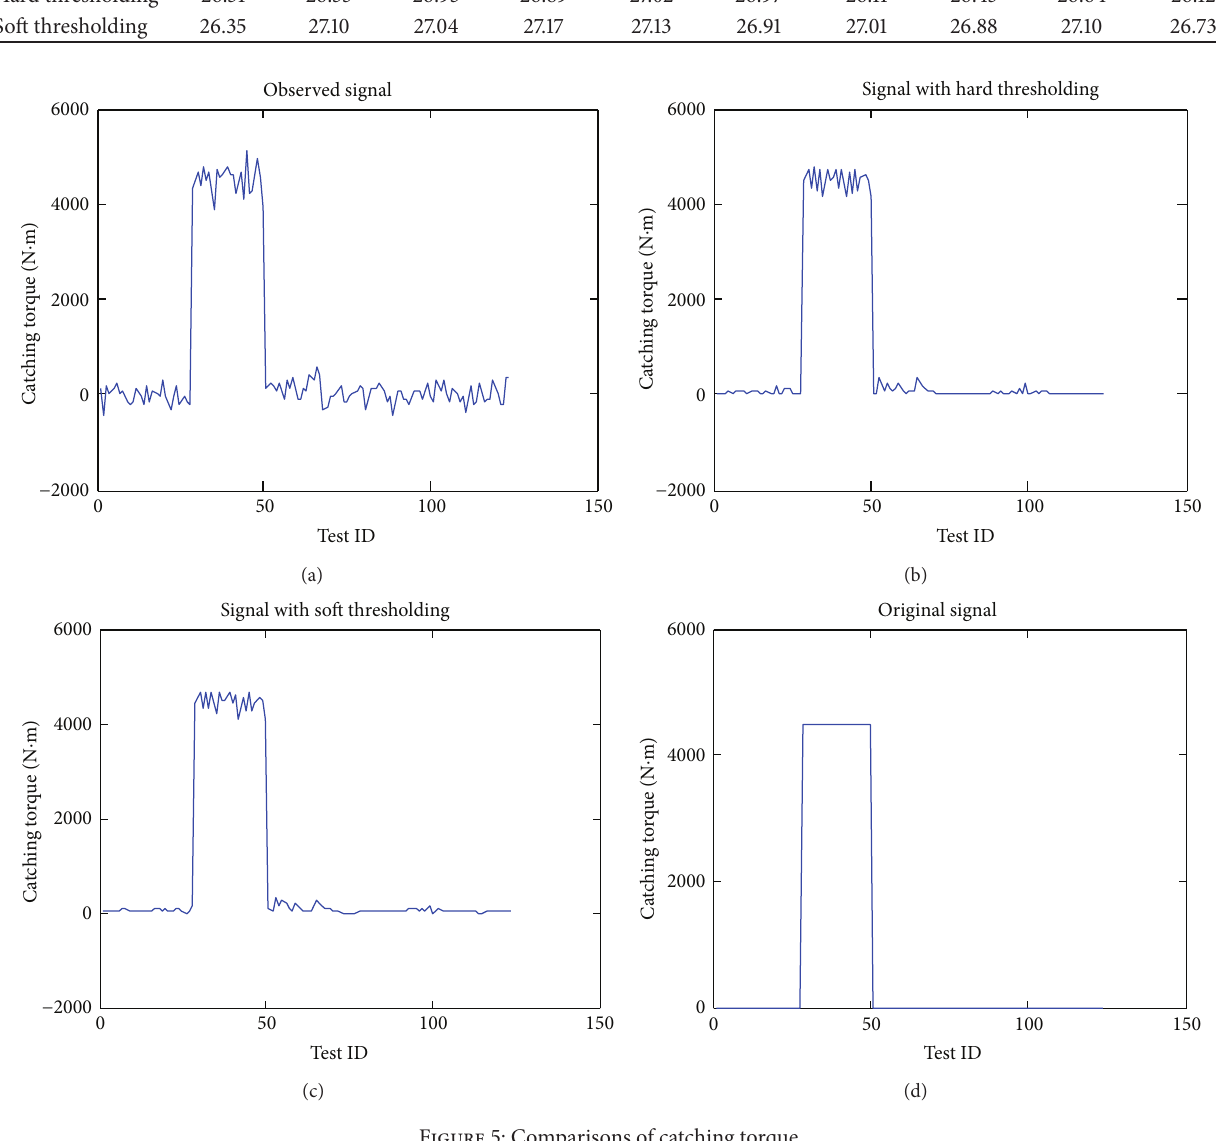
Figure 5: Comparisons of catching